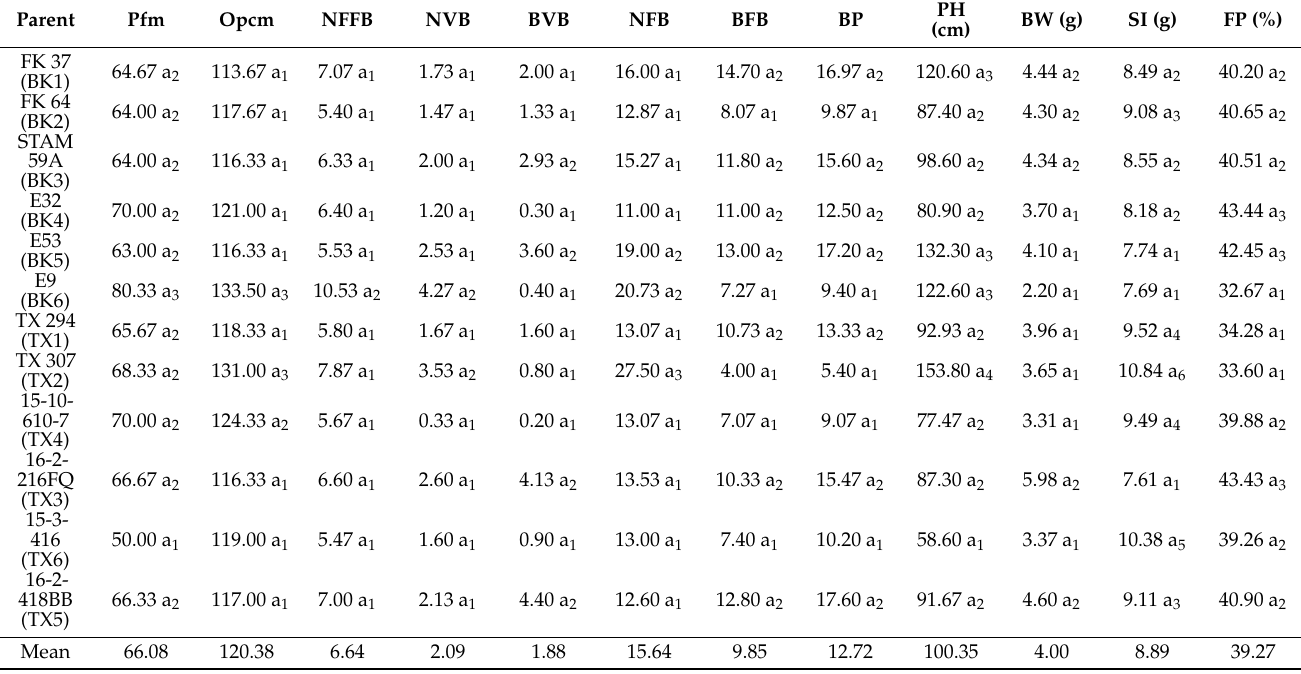
Table 1. Analysis of variance (ANOVA) of agronomic traits of 12 cotton lines, six originated from Burkina Faso and six from the United